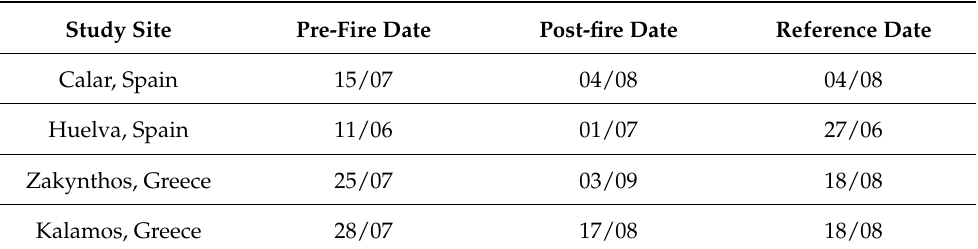
Figure 2. Pre- and post-fire S2 images (first and second column, respectively) for each site: Calar, Spain ( a ); Huelva, Spain ( b ); Kalamos, Greece ( c ) and Zakynthos, Greece ( d ). S2 images are displayed as RGB false color composites (SWIR2, NIR, RED). In the second column, active fire points from MODIS (red) and VIIRS (yellow) are overlaid on the RGB image. Table 2. Pre-fire and post-fire S2 image dates. The reference date is the date of the EMS dataset used for validation in the four study